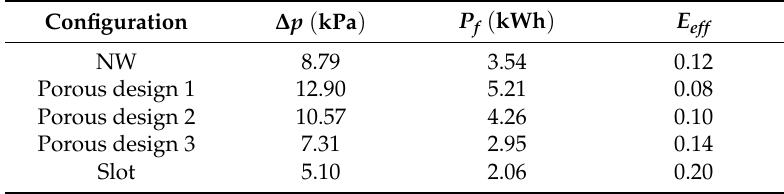
Table 2. Energy efficiencies for different contact tank